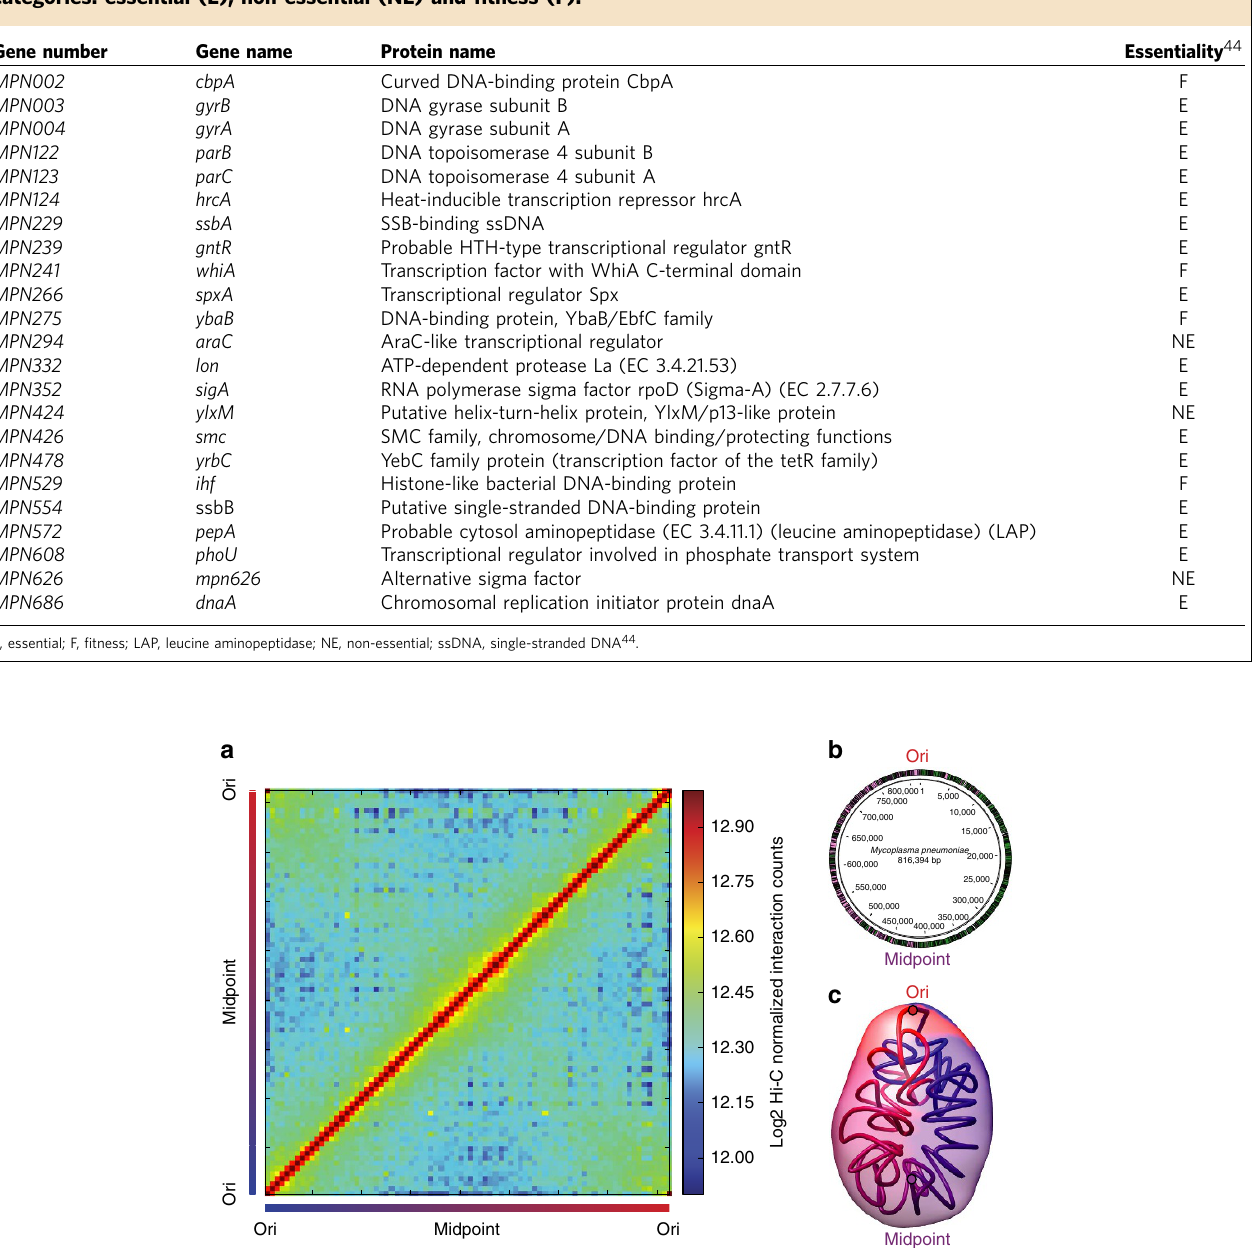
Table 1 | List of assigned transcription factors, sigma factors and structural proteins and essentiality with three distinct categories: essential (E), non - essential (NE) and fitness